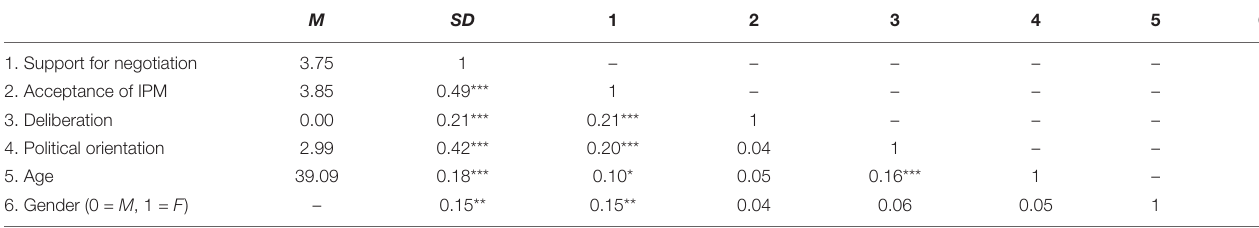
TABLE 3 | Descriptive statistics and bivariate correlations (Study 2). M SD